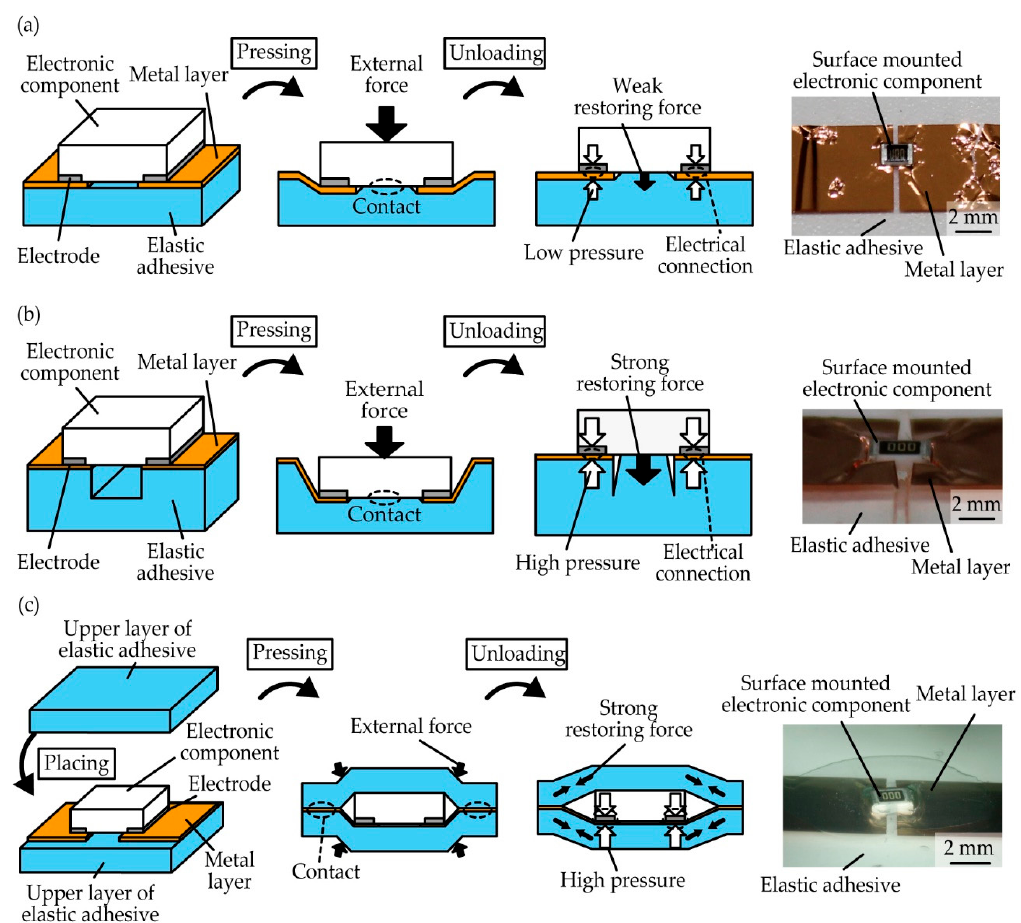
Figure 7. Schematic images and optical images of the ( a ) simple adhesive structure, ( b ) concave structure, and ( c ) sandwich structure.